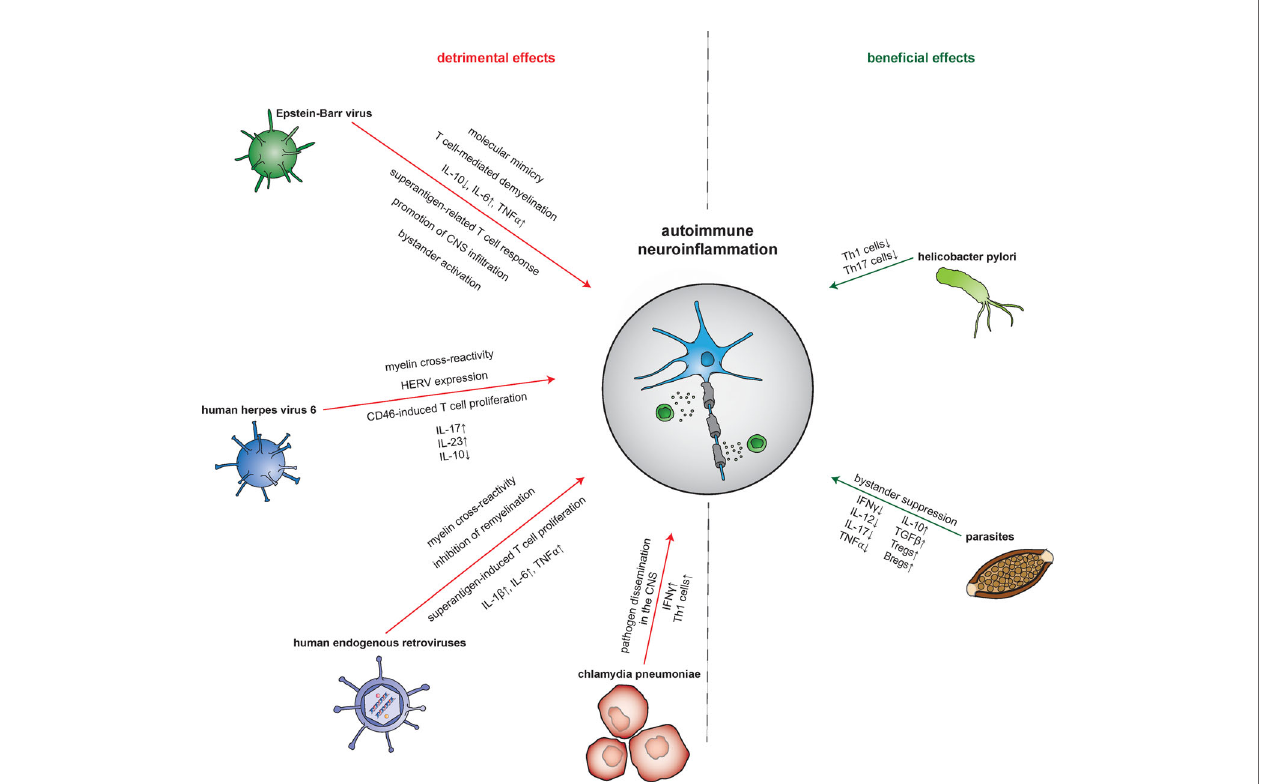
FIGURE 2 | Pathogen-mediated impact on autoimmune neuroin fl ammation. The mechanisms by which infectious pathogens in fl uence the processes of autoimmune neuroin fl ammation are diverse. Both detrimental and bene fi cial effects are reported. Epstein-Barr virus (EBV), for example, leads to an increase in neuronal damage via molecular mimicry, demyelination, an increase in pro- and decrease in anti-in fl ammatory molecules, and an augmented T cell response. Other pathways by which EBV induces ampli fi cation of the neuroin fl ammatory response include promotion of central nervous system (CNS) in fi ltration by autoreactive T and B cells next to bystander activation. Meanwhile, human herpes virus 6 (HHV-6) leads to a detrimental impact via CD8 + T cell-mediated cross-reactivity with myelin peptides and CD46-induced promotion of T cell proliferation. Furthermore, HHV-6 also triggers the expression of human endogenous retroviruses (HERVs) proteins. These in turn induce further damage via cross-reactivity with myelin antigens but also through acting as superantigens. Contributing to this is as well, HERVs trigger CD14- as well as Toll-like receptor (TLR) 4-mediated induction of proin fl ammatory cytokines. Interestingly, by suppression of oligodendrocyte precusor cells, HERVs also interfere with neurodegenerative processes. Finally, Chlamydia pneumoniae was shown to aggravate neuroin fl ammation in an animal model through pathogen dissemination into the CNS accompanied by an increase of pro-in fl ammatory Th1 cells. In contrast, a bene fi cial impact on the neuroin fl ammatory response was found for H. pylori and parasites. H. pylori improves the outcome in animal models of MS by reducing the proliferation of Th1 and Th17 cells. Parasites such as helminths attenuate the neuroin fl ammatory response by inducing bystander suppression via upregulation of regulatory B and T cells as well as anti-in fl ammatory cytokines. Bregs, regulatory B cells; CNS, central nervous system; HERV, human endogenous retrovirus; IFN, interferon; TGF b , tumor growth factor b ; Th cell, T helper cell; TLR, Toll-like receptor; TNF a , tumor necrosis factor a ; Tregs, regulatory T